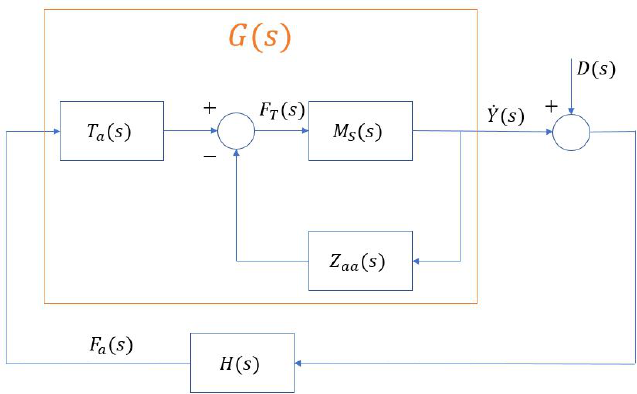
Figure 1. Control system block